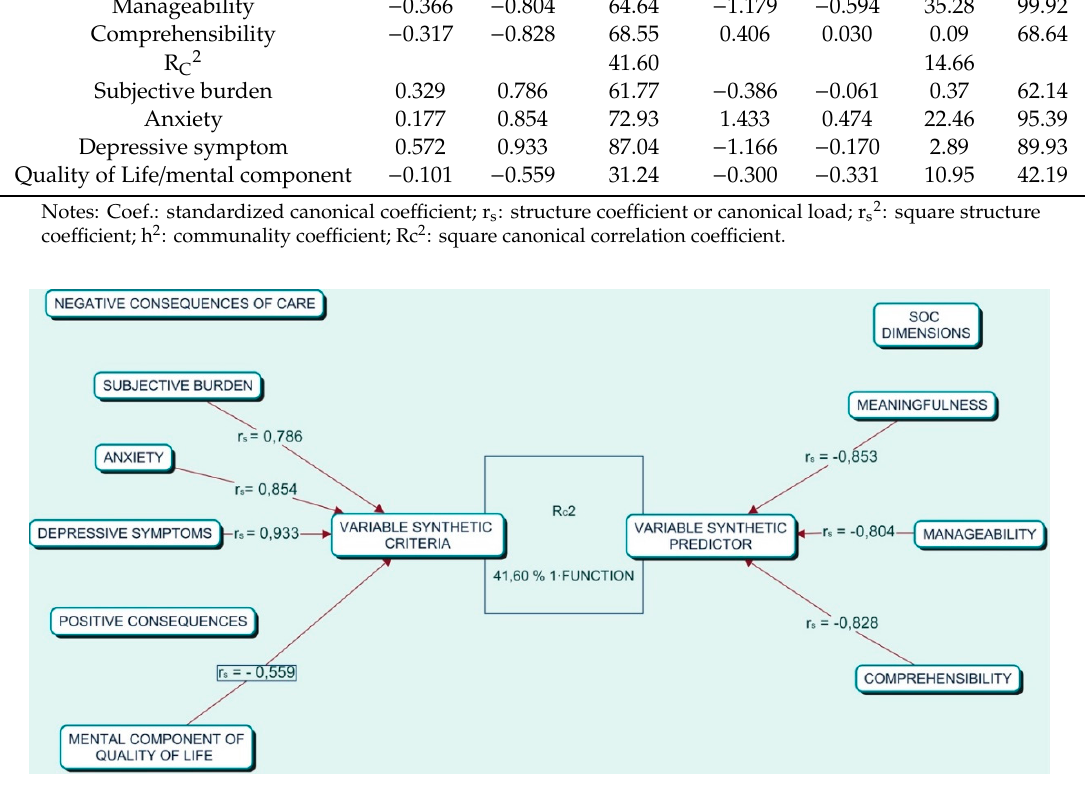
Table 2. Canonical results for sense of coherence (SOC) dimensions and positive and negative consequences for each function.